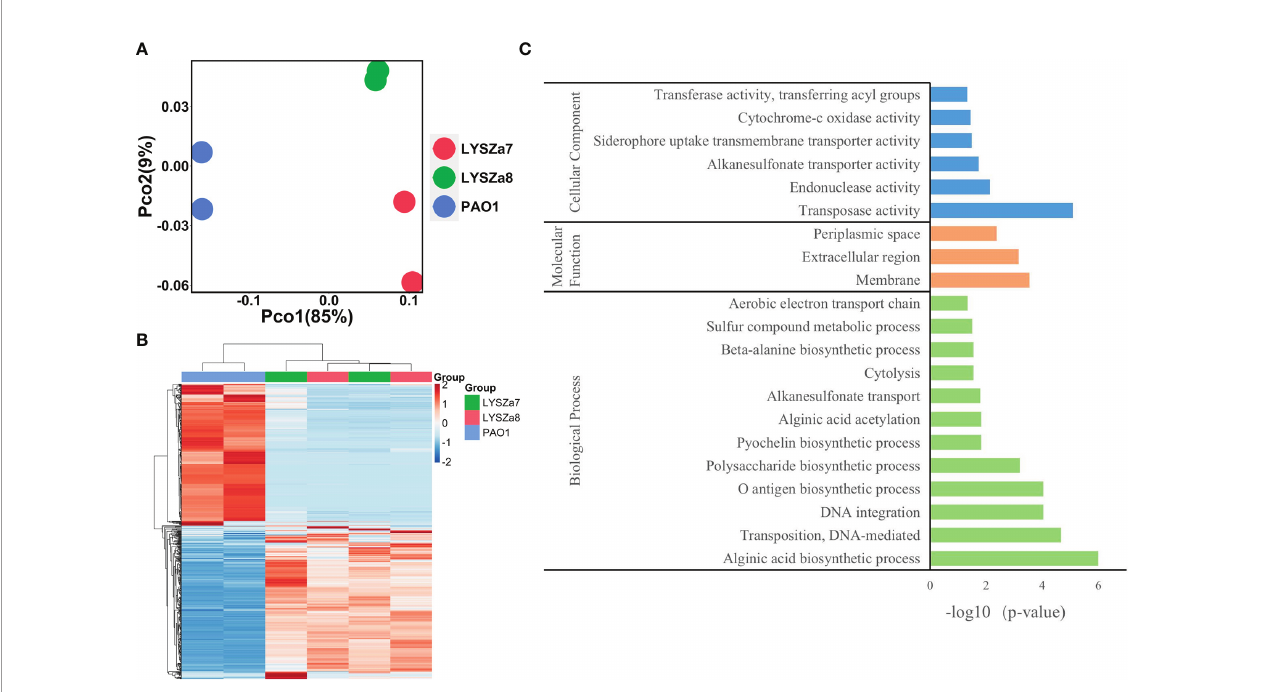
FIGURE 5 | Dissimilarity analysis of samples and Gene Orthology analysis of differentially expressed genes; (A) PCoA plot of P. aeruginosa PAO1, LYSZa7 and LYSZa8 by Bray Curtis dissimilarity; (B) Heatmap of PAO1, LYSZa7 and LYSZa8 based on euclidean clustering distance; (C) Gene Orthology Enrichment based on the signi fi cantly regulated genes (fold change ≧ 4, adjusted p-value < 0.05) in LYSZa7 comparing to those of